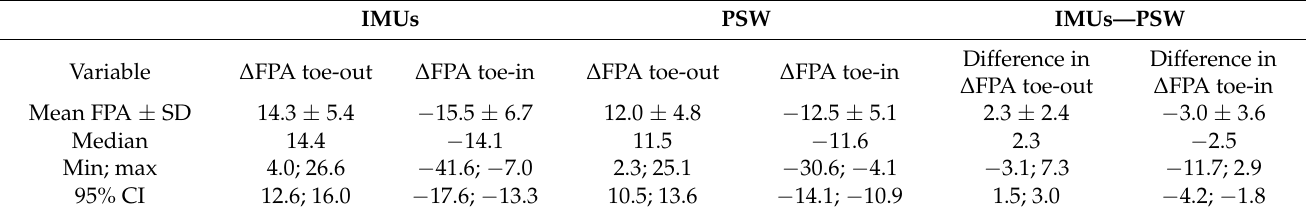
Table 3. Assessment of baseline test-retest intraclass correlation coefficients (ICC) with 95% confidence intervals, standard deviation (SD), standard error of measurement (SEM), and minimal detectable change (MDC) in degrees. IMUs PSW Baseline Test-Retest Baseline Test-Retest ICC absolute agreement 0.89 0.97 (95% CI) (0.79; 0.94) (0.95; 0.99) p < 0.001 p < 0.001 SEM ( ◦ ) 1.6 MDC ( ◦ ) Table 4. ∆ FPA in degrees for toe-out gait and toe-in gait for both systems, and difference in ∆ FPA between the systems. ∆ FPA is calculated by subtracting the baseline FPA from the toe-out gait or toe-in gait FPA. All variables are in